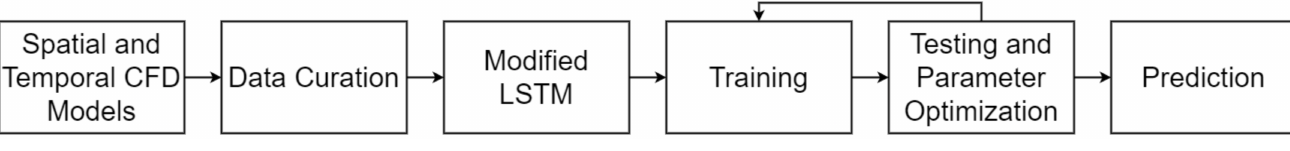
Figure 1. Research